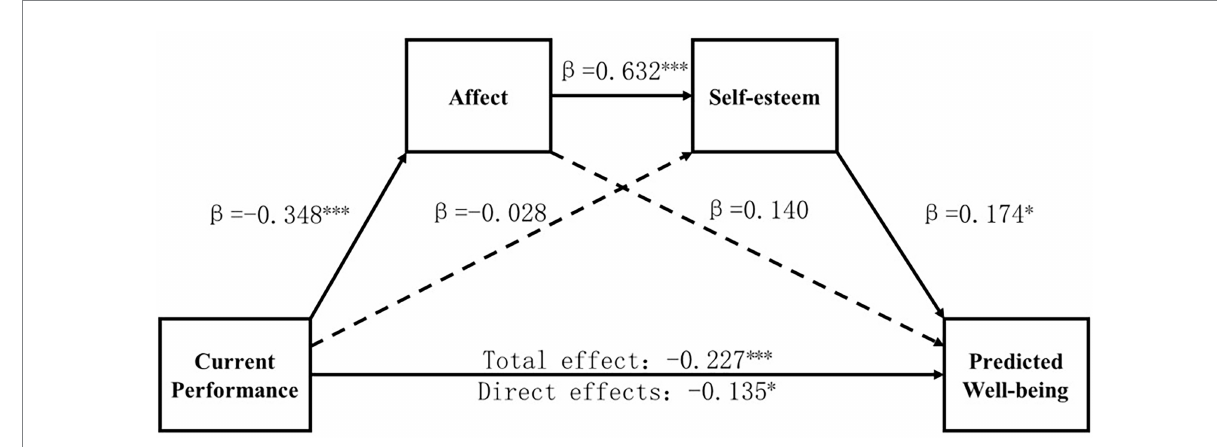
FIGURE 1 Chain intermediary model in high self-threat situation ( N = 209). * p <0.05, *** p <0.001.